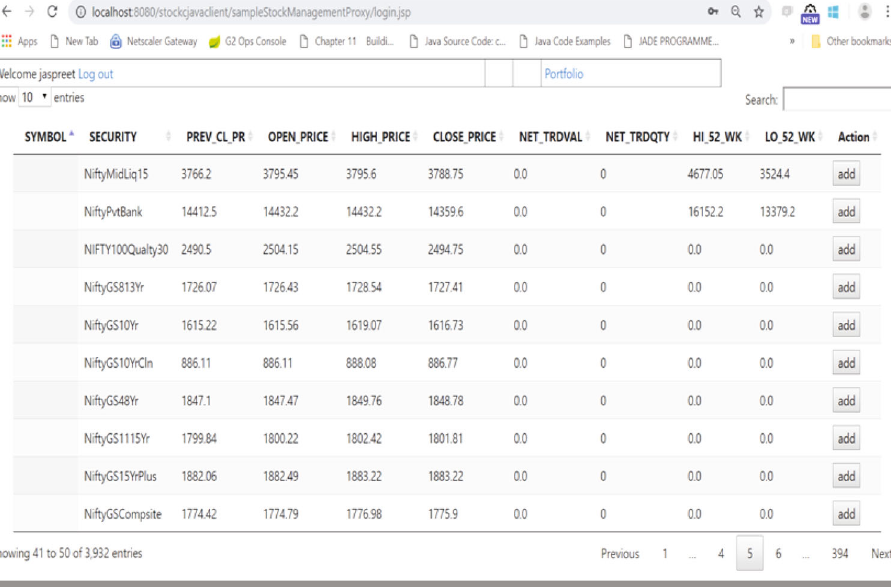
Figure 6: Snapshots of stock